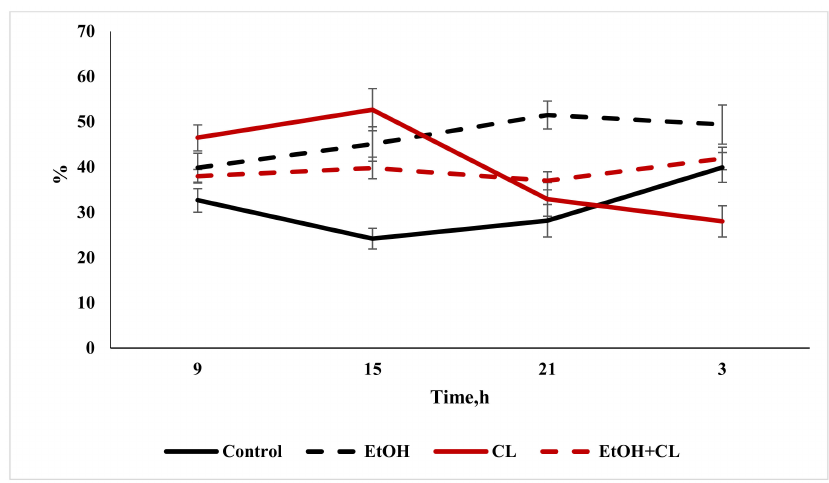
Figure 20. Daily fluctuations in the expression of Per2 in rat hepatocytes.